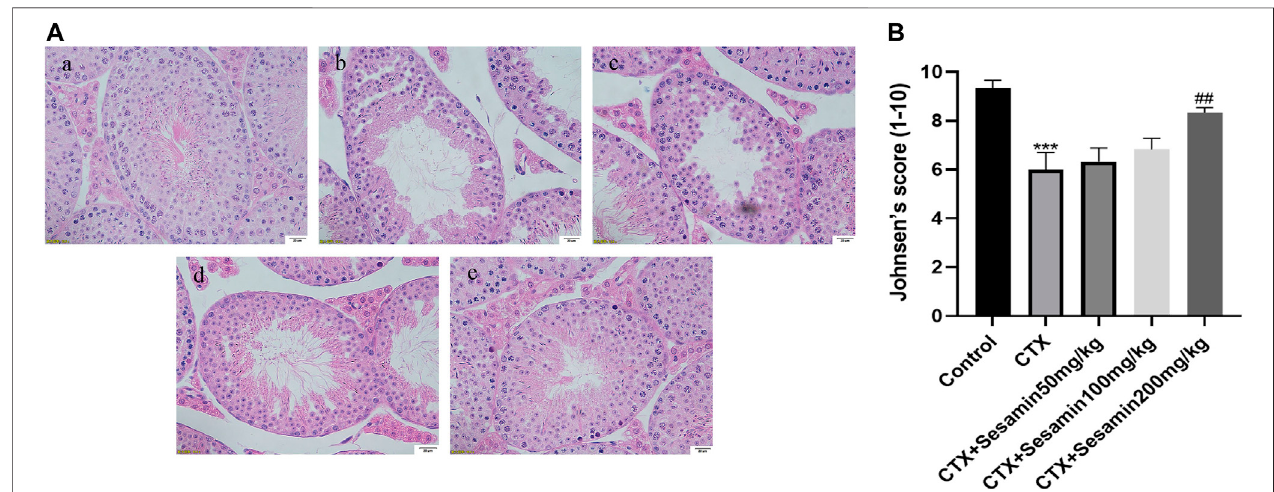
FIGURE 4 | Effects of sesamin treatment on the CTX-induced male mice testicular histopathology. (A) The representative H&E staining photomicrographs in the seminiferoustubulesofthetestis at400 × magni fi cation(scalebar (cid:2) 20 μ m). (a) Controlgroup; (b) CTX group; (c – e) CTX+sesamingroups(50, 100,or 200 mg/kg). (B) Johnsen ’ s testicular score. Each bar indicates the mean ± standard error (n (cid:2) 6). *** p < 0.001 vs. the control group; ## p < 0.01 vs. the CTX group.